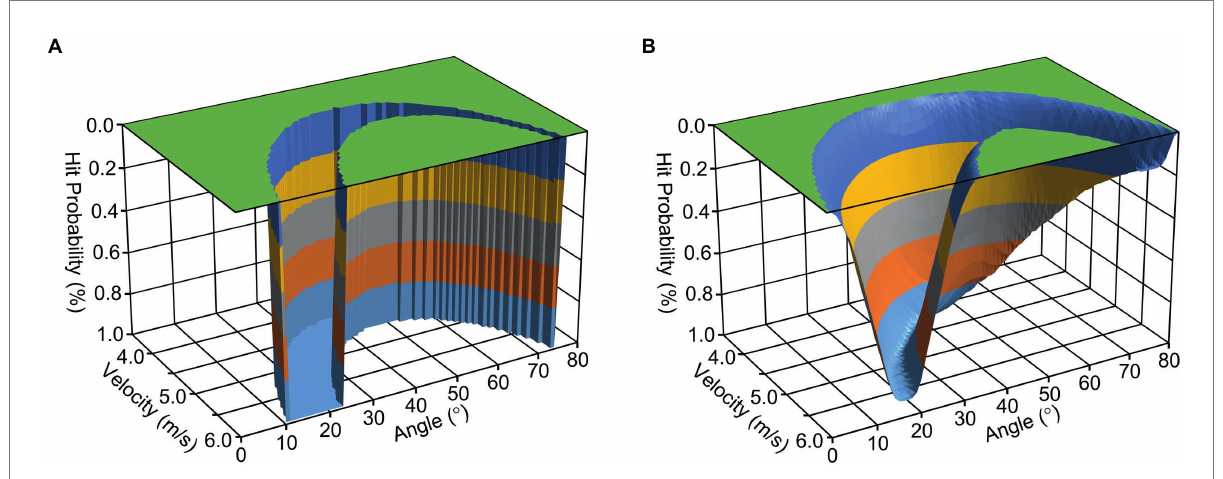
FIGURE 1 Task-space landscapes for dart throwing without (A) and with (B) considering sensorimotor